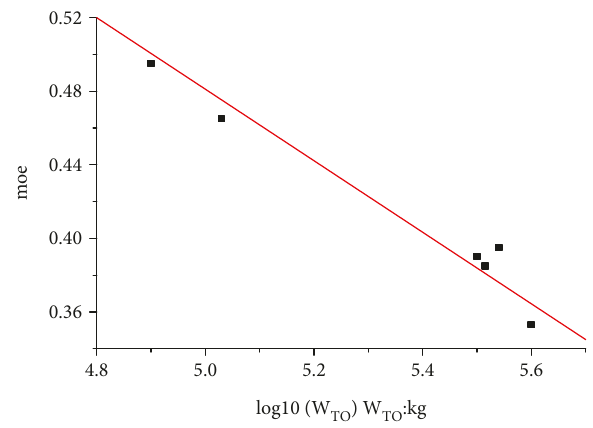
Figure 5: The relation between moe and W civil